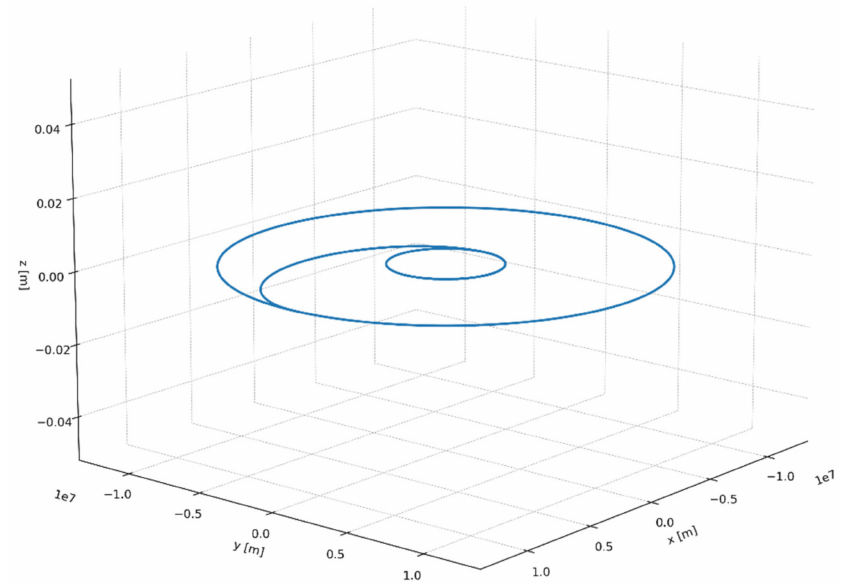
Figure 12. Three-dimensional representation of the Hohmann Transfer.